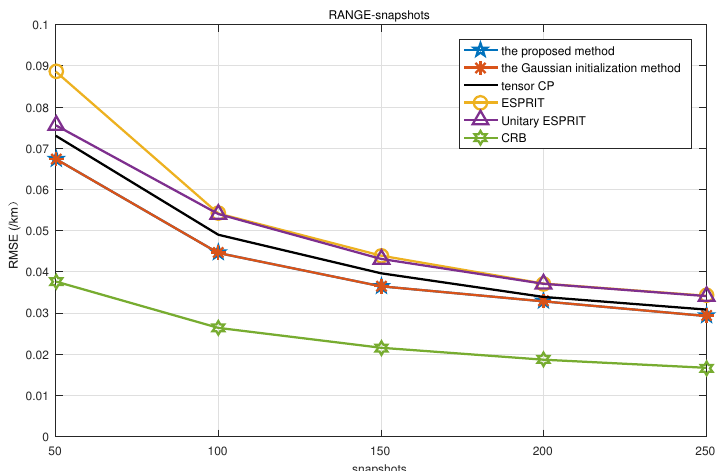
Figure 6. RMSE of range estimation versus snapshots.